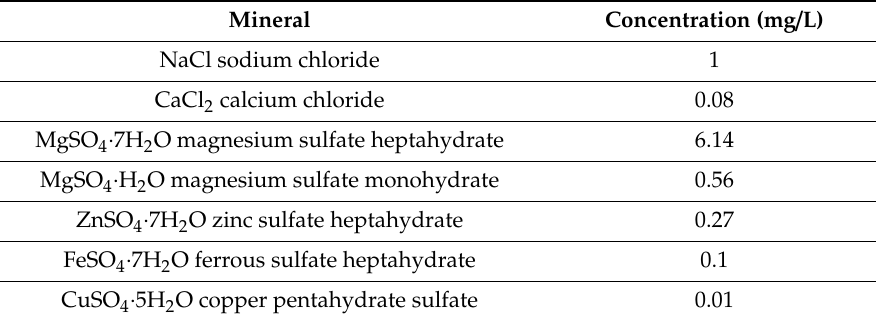
Table 3. Formulation of trace mineral element